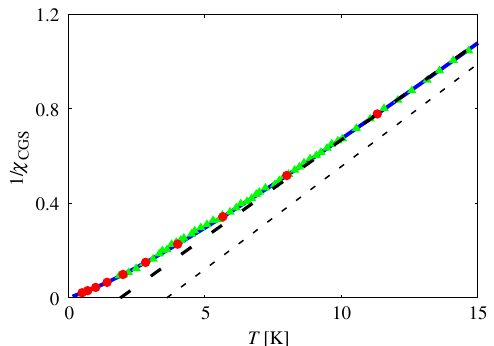
FIG. 5. 1 =(cid:4) vs T for bulk-magnetometry measurements of a Ti O (green triangles), Monte Carlo simu- single crystal of Ho 2 2 7 lation of the nearest-neighbor spin ice (red dots), and the analytical result from the Husimi cactus, Eq. (1) (solid blue (cid:4) 2 J ¼ line). The dashed lines show Curie-Weiss laws for (cid:1) CW ¼ 1 : 9 K (thick line). The suscepti- 3 : 6 K (thin line) and (cid:1) CW bility is expressed in CGS units cm 3 mol (cid:1) 1